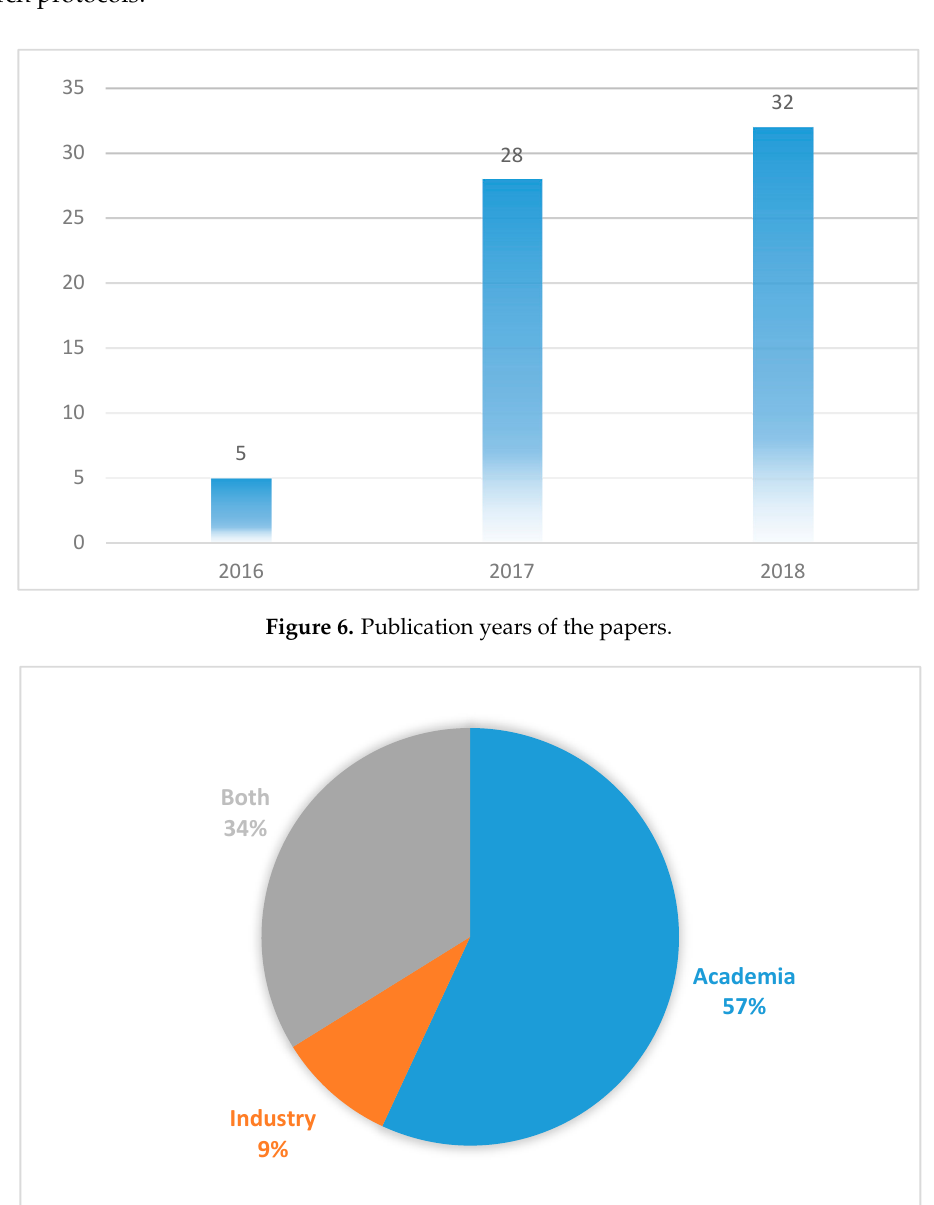
Figure 7. Sources of the papers.